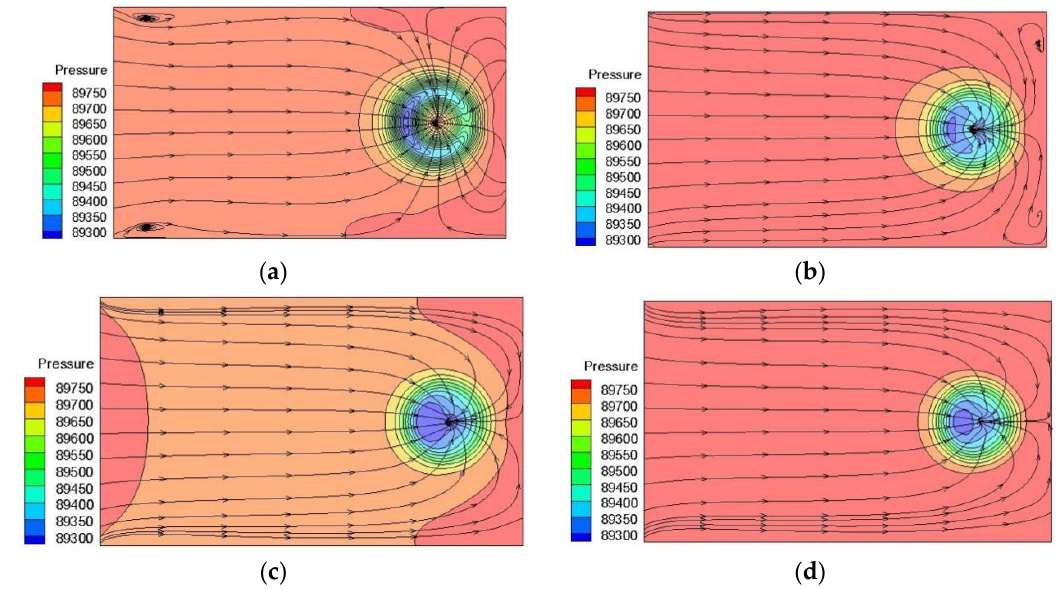
Figure 19. Pressure distribution of section 2-2 with different floor clearance. ( a ) Case 11, ( b ) Case 6, ( c ) Case 12 and ( d ) Case 13.